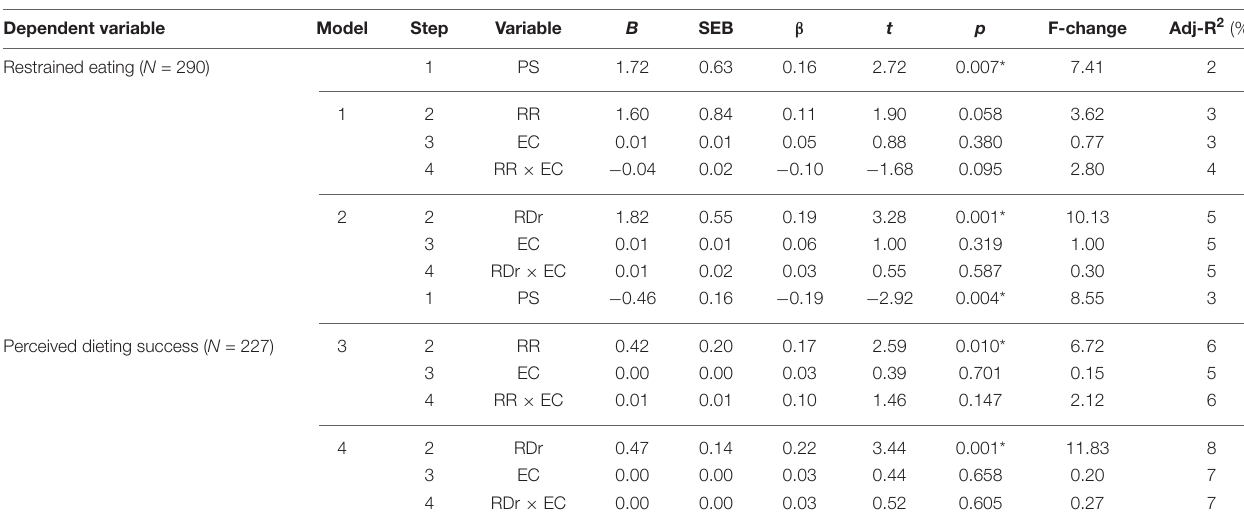
TABLE 3 | Hierarchical regression